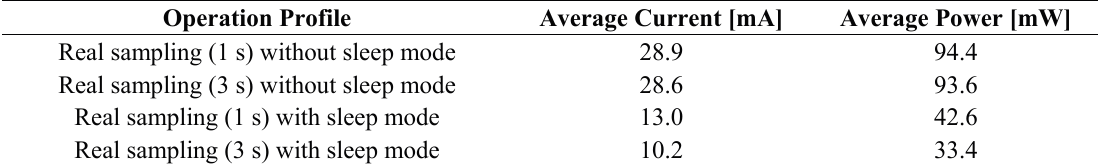
Table 6. Comparison of power and current consumption of the wireless sensor module. WNCS using the soft sensor with Multi-rate of 0.1